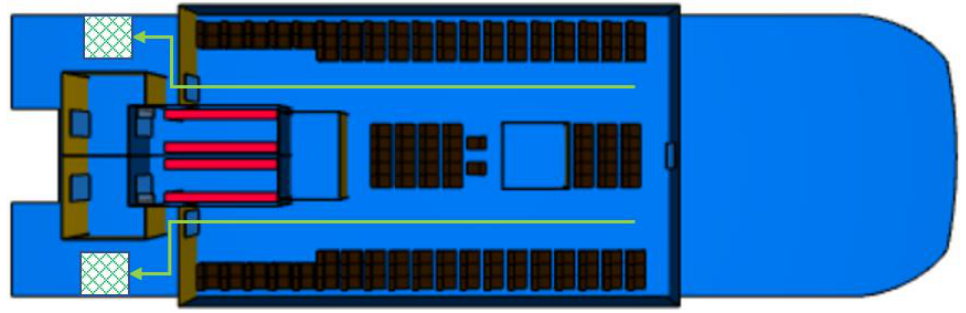
Figure 8. Ferry evacuation plan.